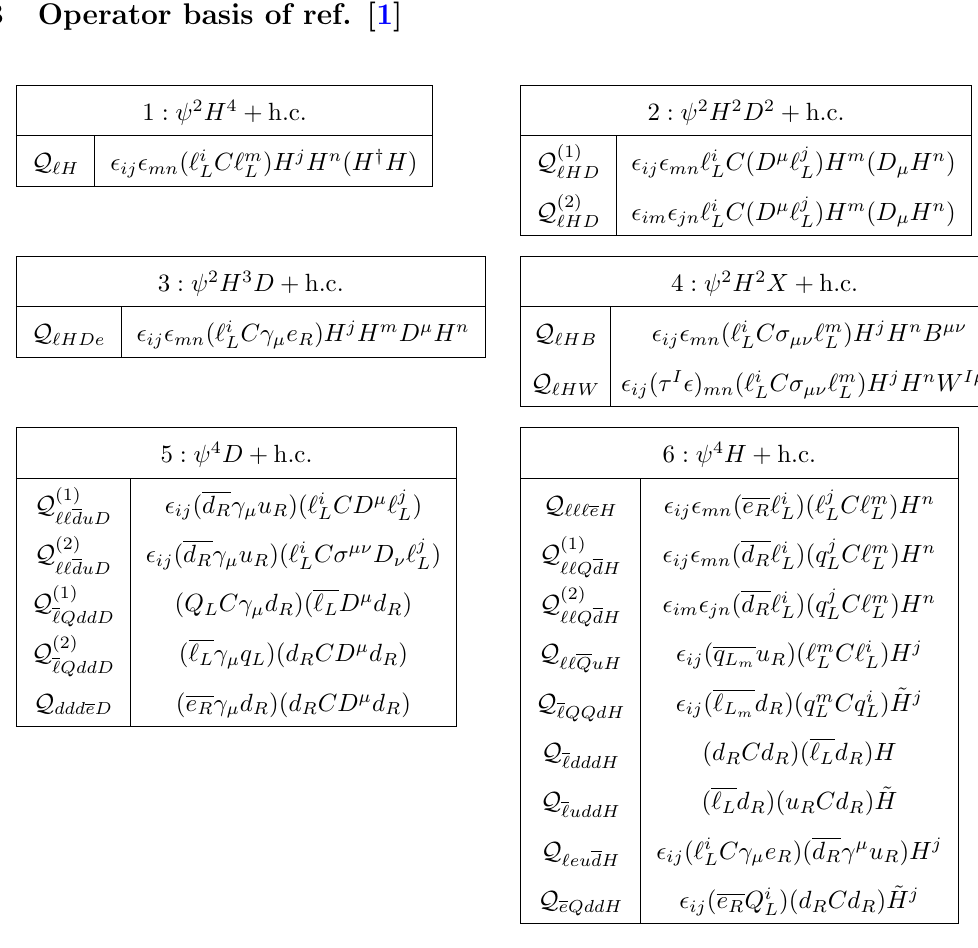
The operator basis of ref. [1] matched onto in this work. Here the spinors are in four component notation and C = (cid:0) i(cid:13) 2 (cid:13) 0 in the chiral basis we employ. Open